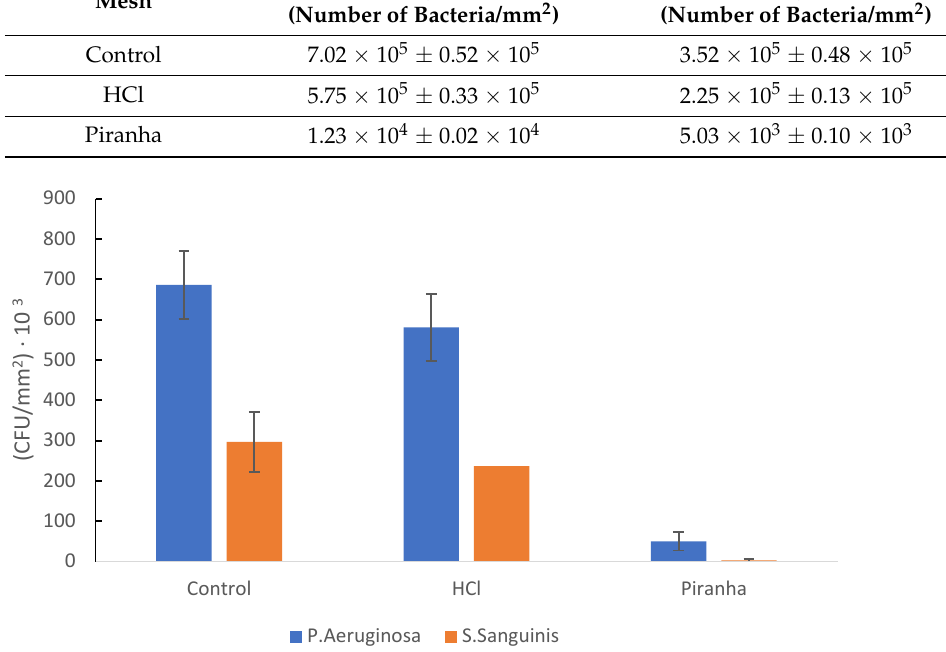
Figure 9. Analysis of P. aeruginosa and S. sanguinis adhesion for the three different conditions.